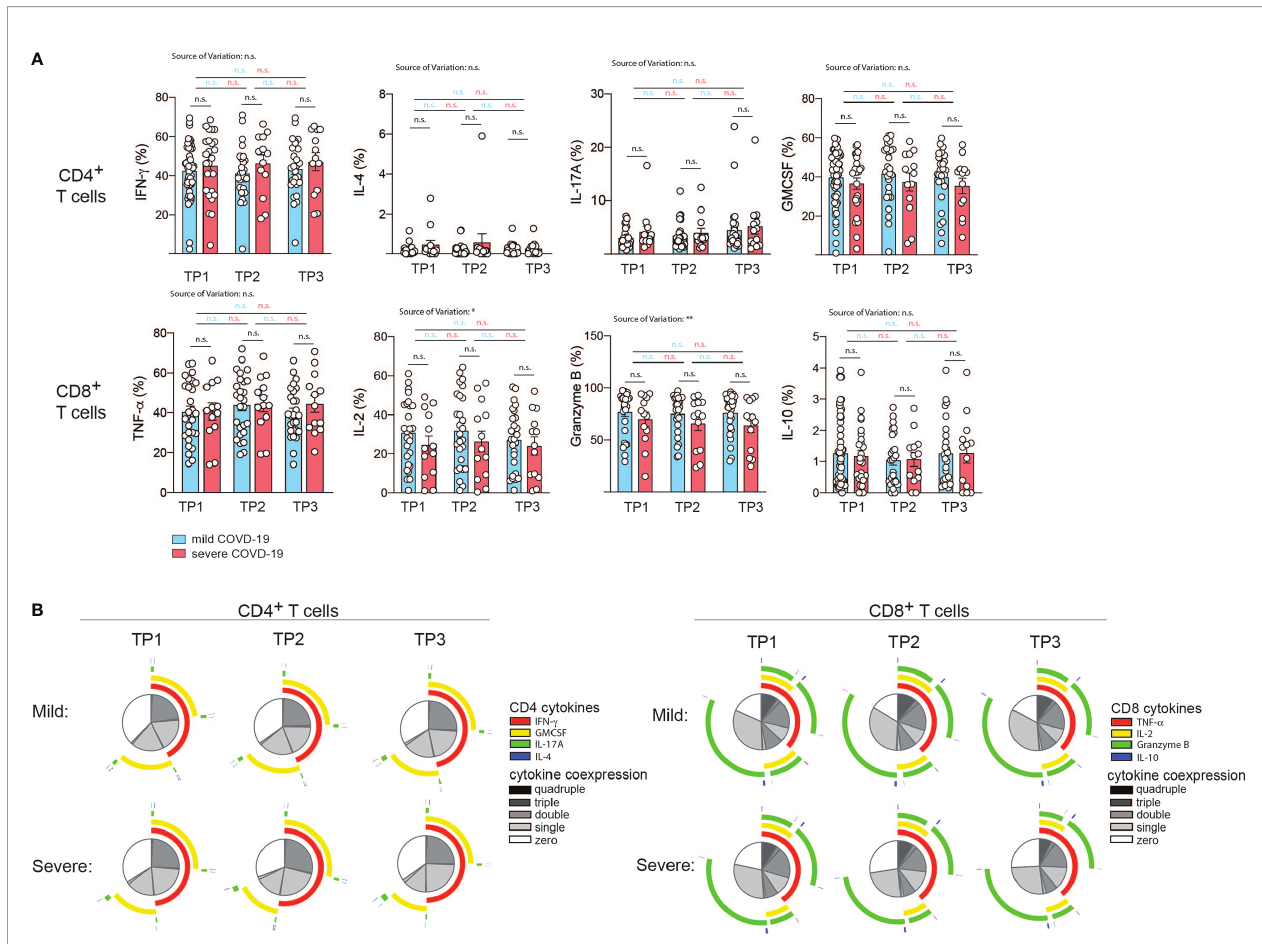
FIGURE 4 | Correlation of COVID-19 severity with T cell cytokine production and T cell polyfunctionality over time. (A, B) Intracellular cytokine staining and fl ow cytometry of PBMC gated on CD3 + and CD4 + versus CD8 + T cells after 72 h of stimulation with CD3 and CD28 mAbs. (A) , Intracellular cytokine expression in CD4 + versus CD8 + T cells. Each circle represents one patient. *P < 0.05, **P < 0.01. (B) Polyfunctionality analysis with the SPICE software v.6 (60). The T helper cell signature cytokines IL-4, IFN- g , IL-17A and GM-CSF were analyzed in the CD4 + T cell compartment. For analysis of CD8 + T cells, TNF- a , IL-2, granzyme B and IL-10 were